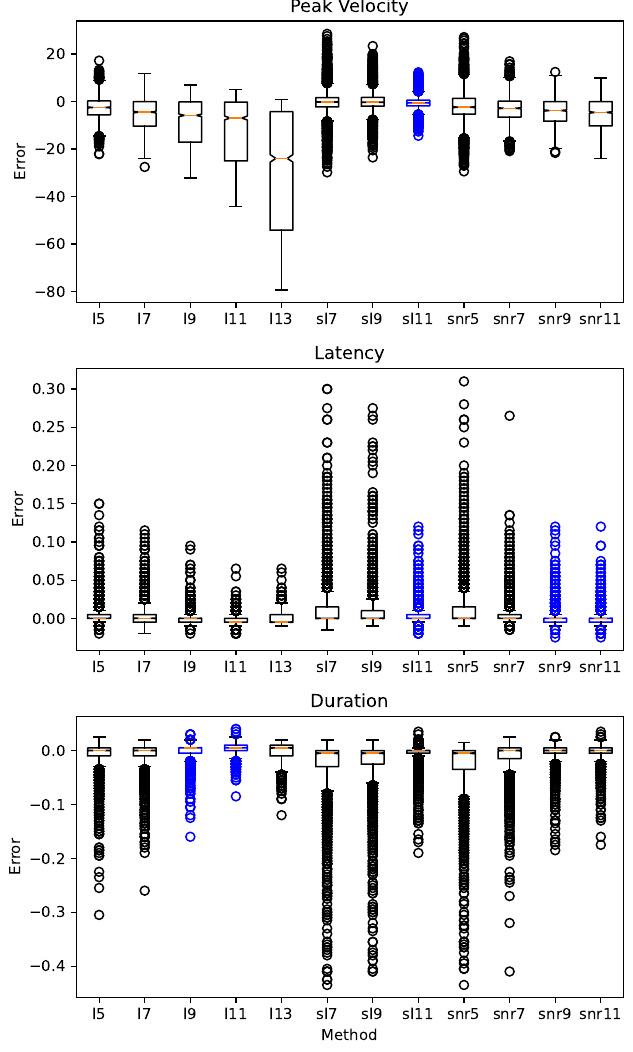
Figure 5. Biomarker computing errors box plot by method. Methods highlighted in blue for each task are those that show no significant difference with the first ranked using Wilcoxon post-hoc